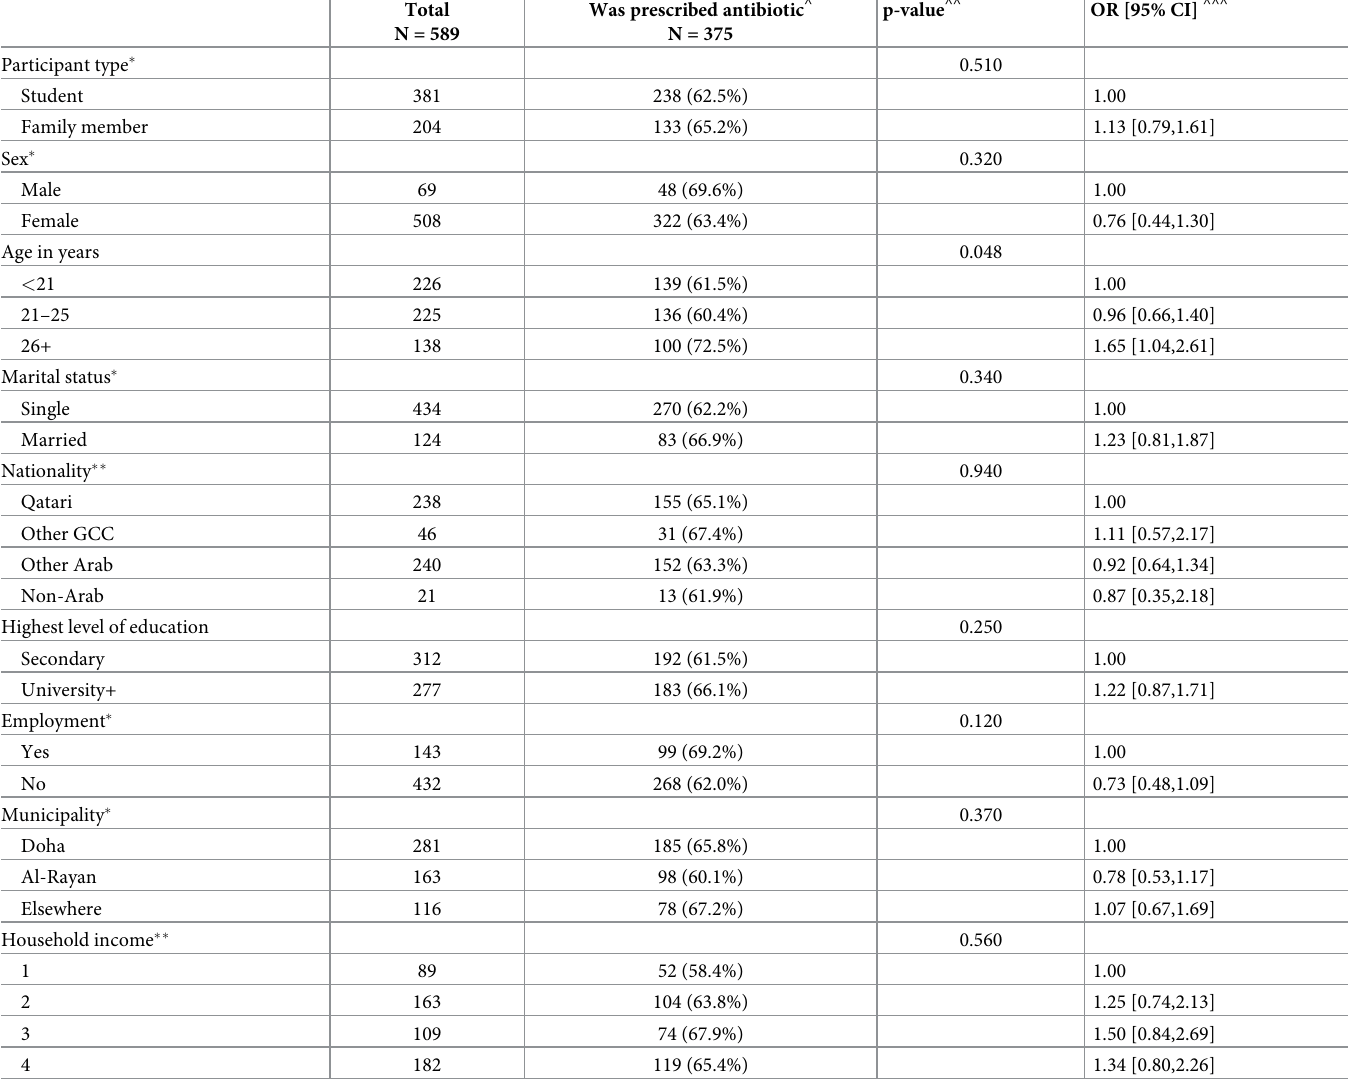
Table 2. Association between respondents’ characteristics and using antibiotics with